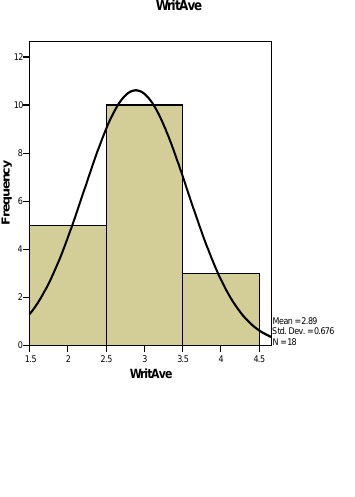
Histogram of the Writing Subtest Scores for Intermediate Level ( N